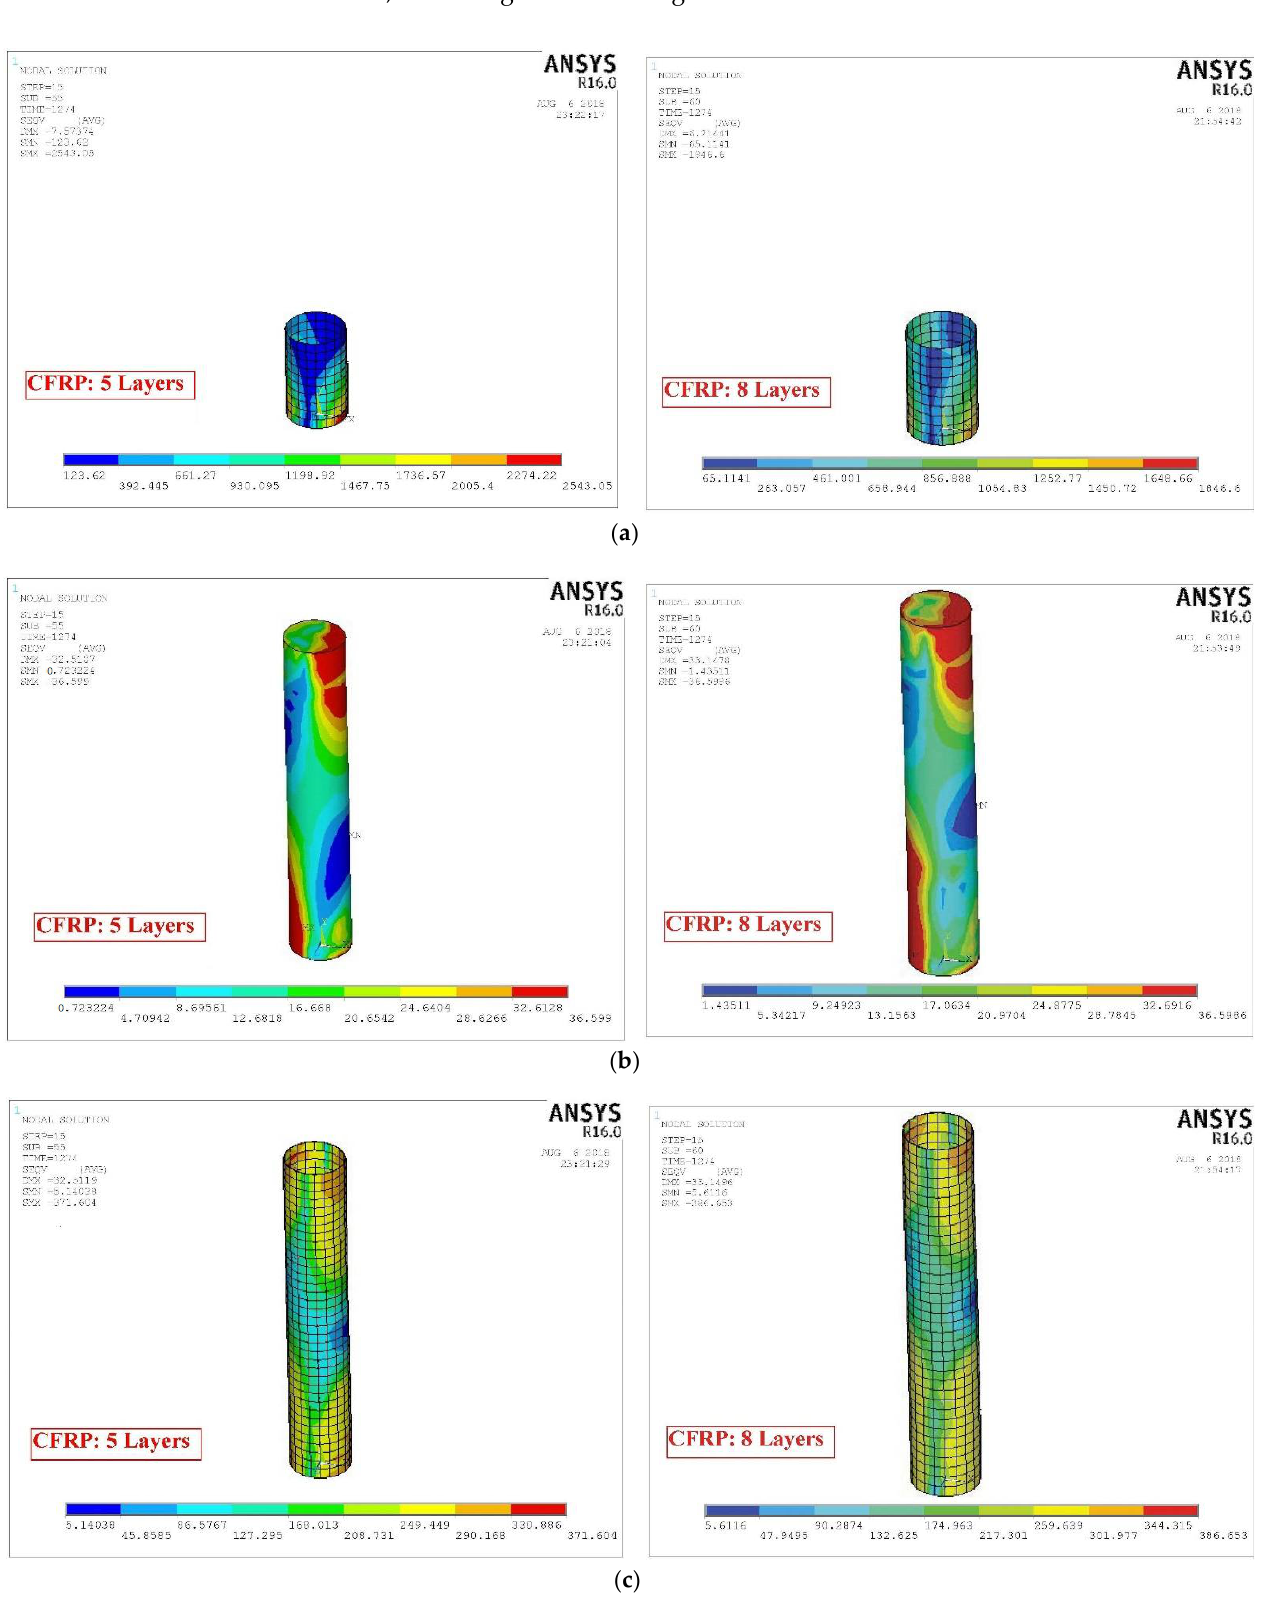
Figure 6. Typical stress contours for sulfate level 1: ( a ) CFRP, ( b ) concrete, and ( c ) steel tube.